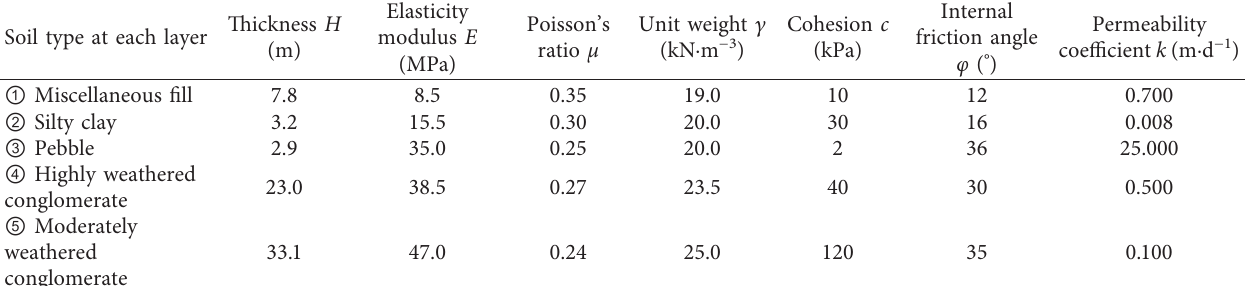
Table 1: Physical mechanical parameters of surrounded layers.